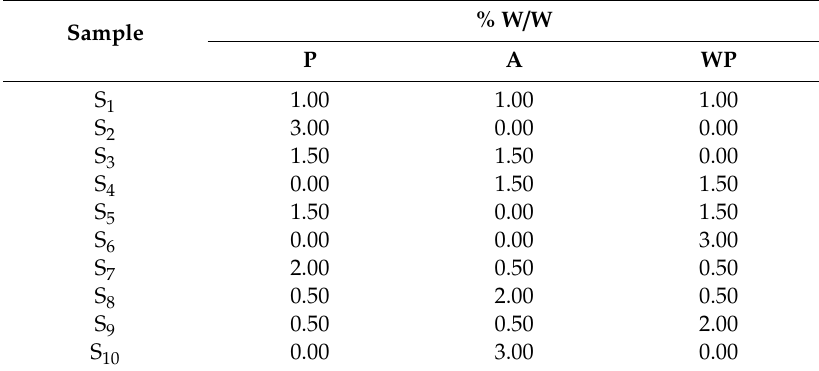
Table 1. Composition of the film forming solutions formulated with pectin, alginate and whey protein concentrate by simplex centroid mixture